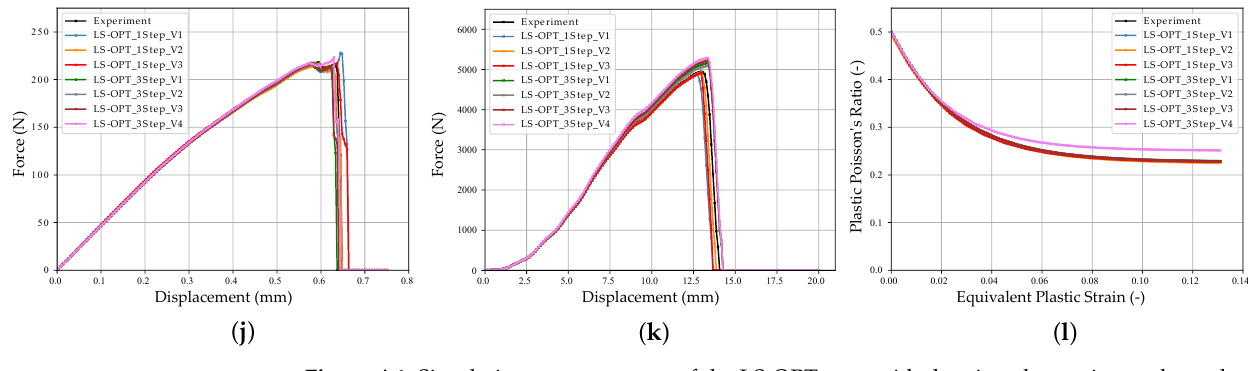
Figure A4. Simulation output curves of the LS-OPT runs with the virtual experimental test dataset: ( a ) FDC tension test; ( b ) FDC compression test; ( c ) PEC compression test; ( d ) FDC tension tests V1; ( e ) FDC tension tests V2; ( f ) FDC tension tests V3; ( g ) FDC tension tests V4; ( h ) FDC bending test; ( i ) FDC shear1 test; ( j ) FDC shear2 test; ( k ) FDC punch test; and ( l ) PEC punch test.